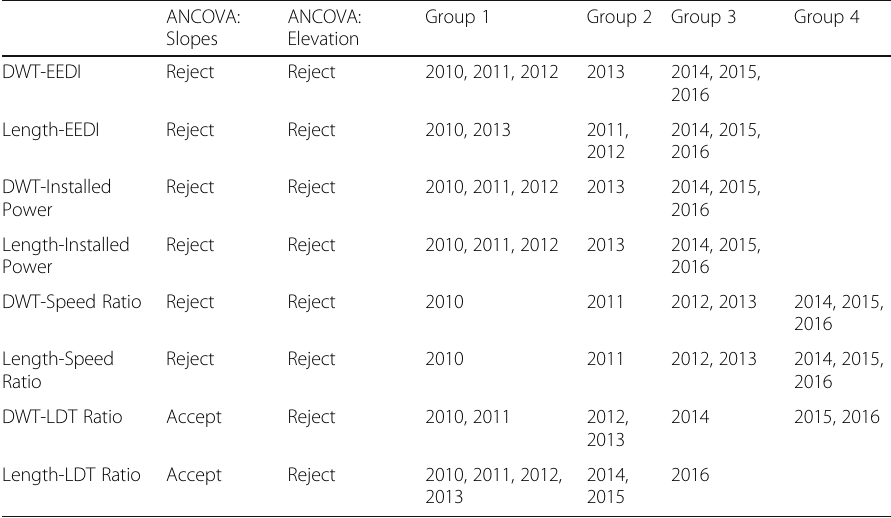
Table 5 Results for significant difference testing of EEDI over the years ANCOVA: